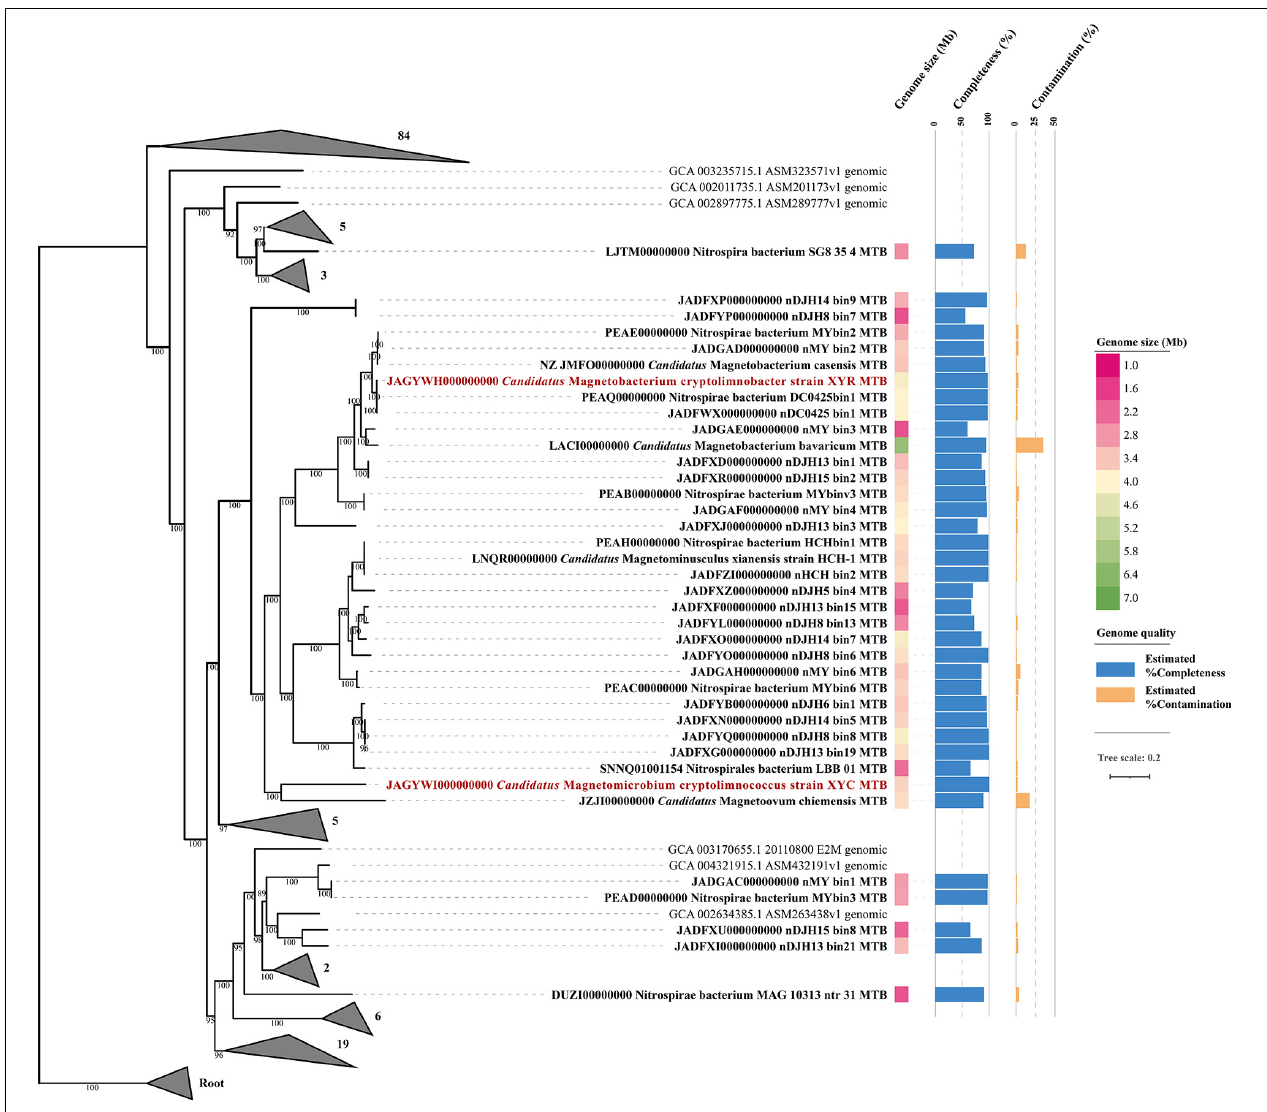
FIGURE 2 | Phylogenomic analysis of 138 Nitrospirae genomes including 38 MTB genomes. A maximum likelihood tree was constructed using a concatenated alignment of 120 conserved bacterial markers with GTDB-Tk (120 conserved bacterial marker genes are provided by GTDB). Numbers at nodes are bootstrap support values ( n = 1,000, only bootstrap values greater than 75% are shown). The genome size and quality of each MTB genome were